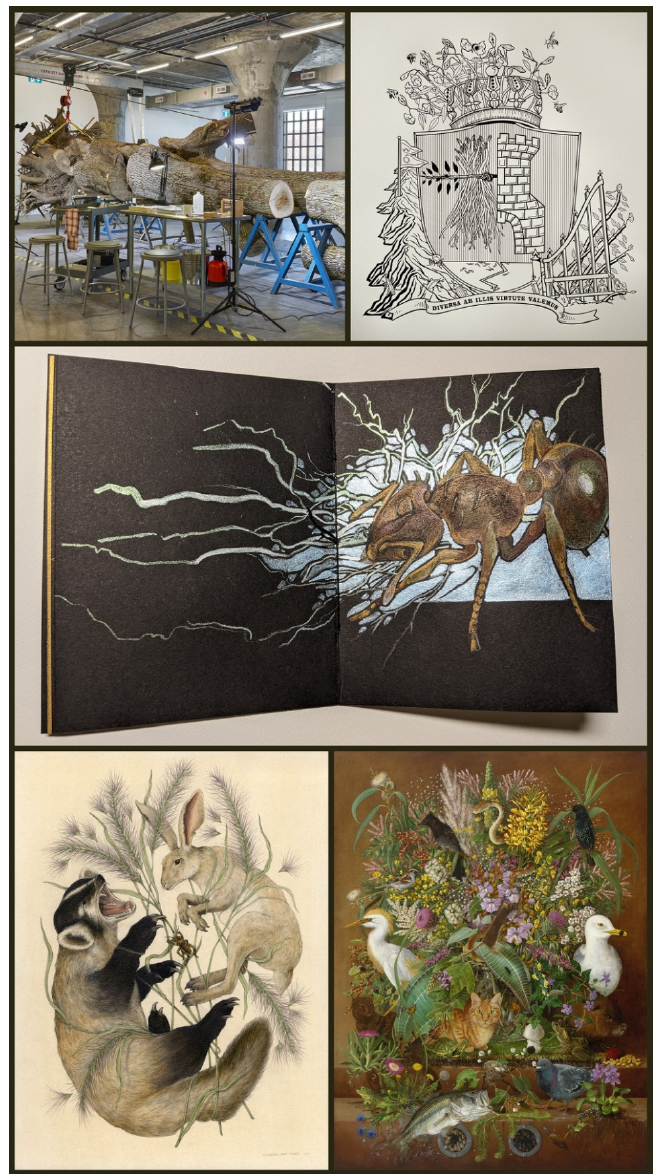
Figure 4. Insect art addressing invasive species. The emerald ash borer ( Agrilus planipennis Fairmaire, 1888) is the invasive species in Life of a Dead Tree ( top left ; 2019), in which Mark Dion worked with entomologists to collect insects from the felled, 140-year-old tree. Marina Zurkow’s Heraldic Crests for Invasive Species series features the invasive Himalayan Balsam ( top right ; letterpress print, 2011), with two beetles as its enemies: Acropteroxys gracilis (Newman, 1838) and Mecinus janthinus Thomson, 1865. Insects “are not the invaders; rather, they’re taking advantage of anthropogenically caused ecosystem imbalances.” A lighter (but still electric) approach is taken by Karen Anne Klein in her Invaders handmade book series ( middle ; Electric Ants ; color pencil and inks, 2022). A lone Jerusalem cricket ( Stenopelmatus monahansensis Stidham and Stidham, 2001) floats between badger and jackrabbit in Elizabeth Jean Younce’s A Moment so Rare from The Withering series ( bottom left ; graphite and watercolor, 2021). The insect is rare in an ecosystem overrun by the invasive Buffelgrass. Twelve invasive species of insects populate Ascendant ( bottom right ; Isabella Kirkland; oil and alkyd, 2000; for key to species see https://www.isabellakirkland.com/; accessed on 5 May 2022). All images are courtesy and copyright of the artists; Zurkow’s image is also courtesy of bitforms